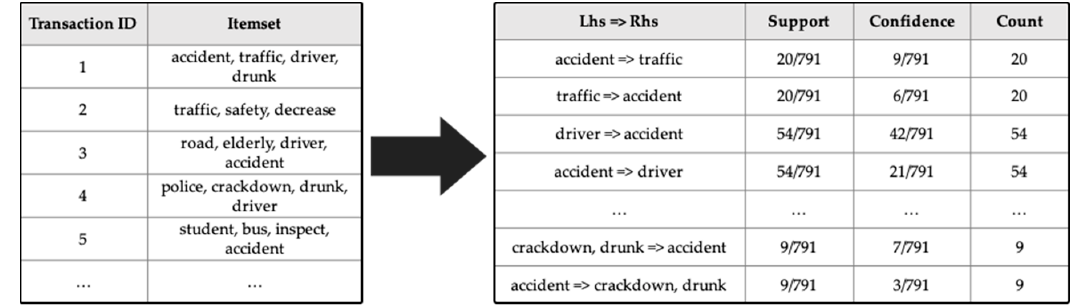
Figure 1. Transaction and Association data generated with the press release of Ministry of Transport.